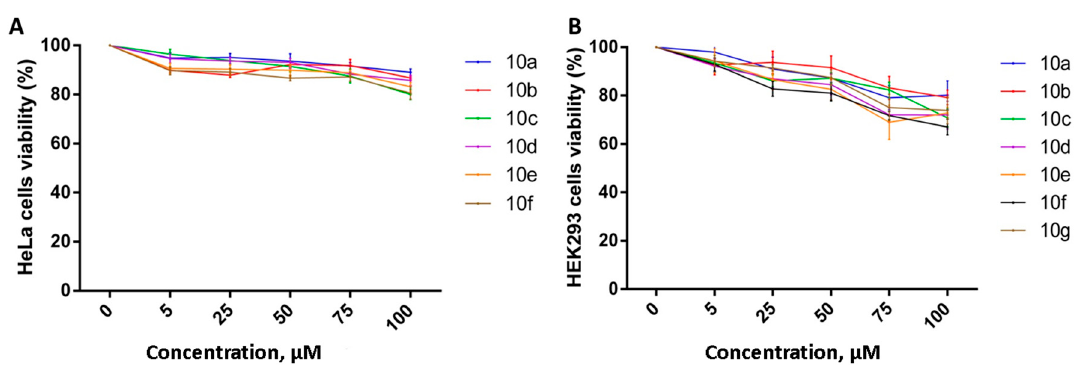
Figure 6. Dose-response curves for HeLa ( A ) and HEK293 ( B ) cells incubated for 24 with different concentrations of the examined compounds. Data points represent mean ± SD for 4 biological replicates.